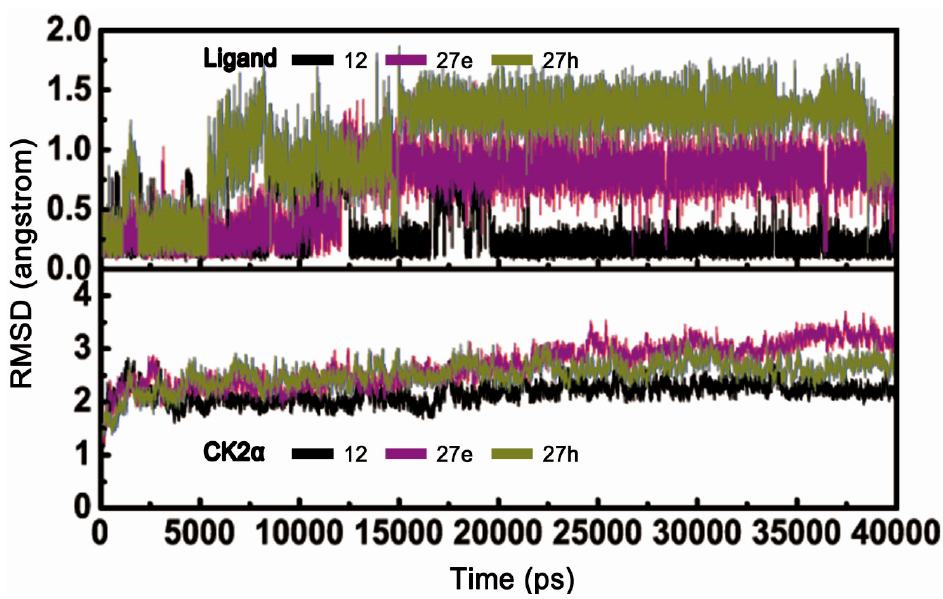
Figure 2. The time dependence of RMSD of inhibitors (upper) and CK2 α (lower) for CK2 in complex with compounds 27e and 27h .